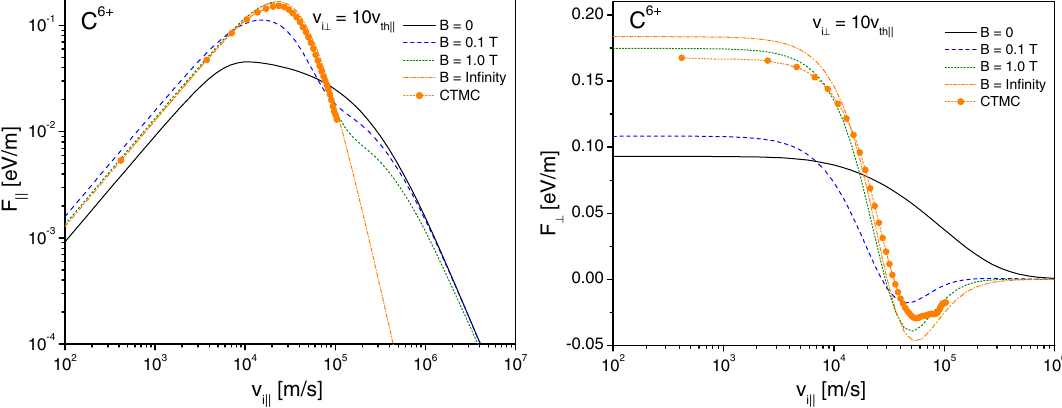
B ¼ 0 isincreasedbyafactor10.